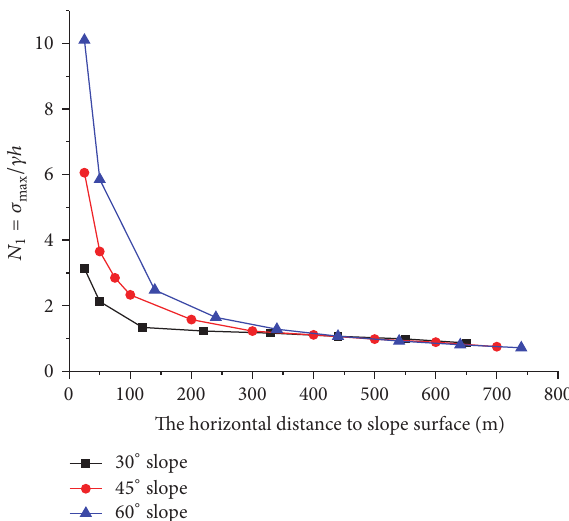
Figure4:Variationcurvesof 𝑁 1 attheelevationof100 mindifferent slope angles only considering the gravity stress.